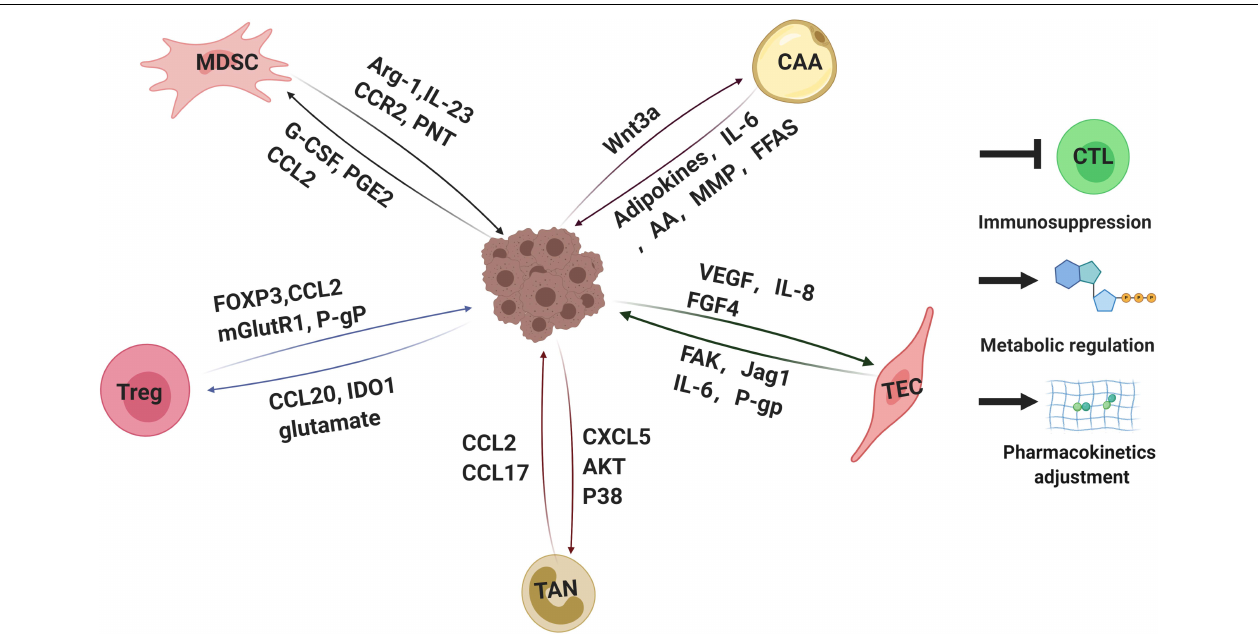
FIGURE 3 | Interactions of tumor cells with parts of non-malignant cells within tumor microenvironments mediating drug resistance. Tumor microenvironment contains quantities of non-malignant stromal cells which are essential for tumor progression and drug resistance. Interactions between tumor cells and stromal cells polarize stromal cells. In turn, the stromal cells educated by tumor cells secret a variety of molecules, leading to immunosuppression, metabolic regulation and pharmacokinetics adjustment, which eventually weakens therapeutic efficacy. Arg-1, arginase-1; IL-23,interlukin-23; PNT, peroxynitrite; G-CSF, granulocyte-colony stimulating factor; PGE2, prostaglandin E2; FOXP3, forkhead box protein P3; mGlutR1, glutamate receptor 1; P-gP: P-glycoprotein, IDO1, indoleamine 2,3-dioxygenase; CAA: cancer associated adipocyte; FFAs: free fatty acids; AA: arachidonic acid; VEGF: vascular endothelial growth factor; FGF4: fibroblast growth factor 4; FAK: focal adhesion kinase. CTL, cytotoxic T lymphocytes. The figure was created with BioRender.com.